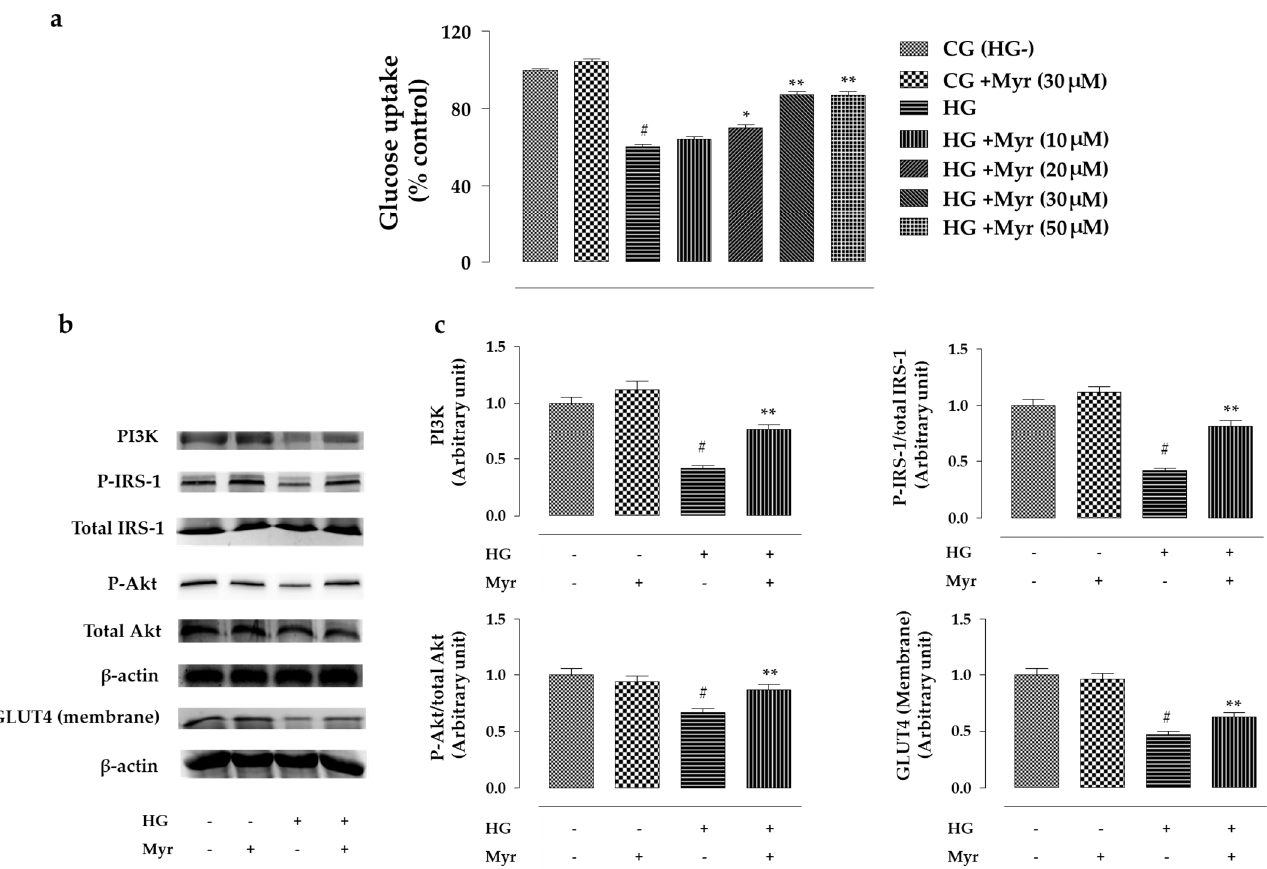
Figure 2. Effect of Myr on glucose uptake events by the skeletal muscle cells. ( a ) Effect of Myr on glucose uptake by L6 cells. ( b ) The immunoblot images showing effects of Myr in the expressions of signal proteins involved in glucose uptake by L6 cells. ( c ) The graphs showing the densitometric analysis of immunoblots. Myr was able to improve glucose uptake by L6 cells by activating PI3K expression, IRS1 phosphorylation, Akt phosphorylation, and GLUT4 translocation to membrane. The intensity of normal control band was assigned 1. β -actin served as the loading control for normalization. Data are represented as the mean ± SD, n (number of plates) = 3. # Values significantly ( p < 0.01) differed from the control (HG − ) group. * Values significantly ( p < 0.05) differed from the HG-treated (HG+) group. ** Values significantly ( p < 0.01) differed from the HG-treated (HG+) group.